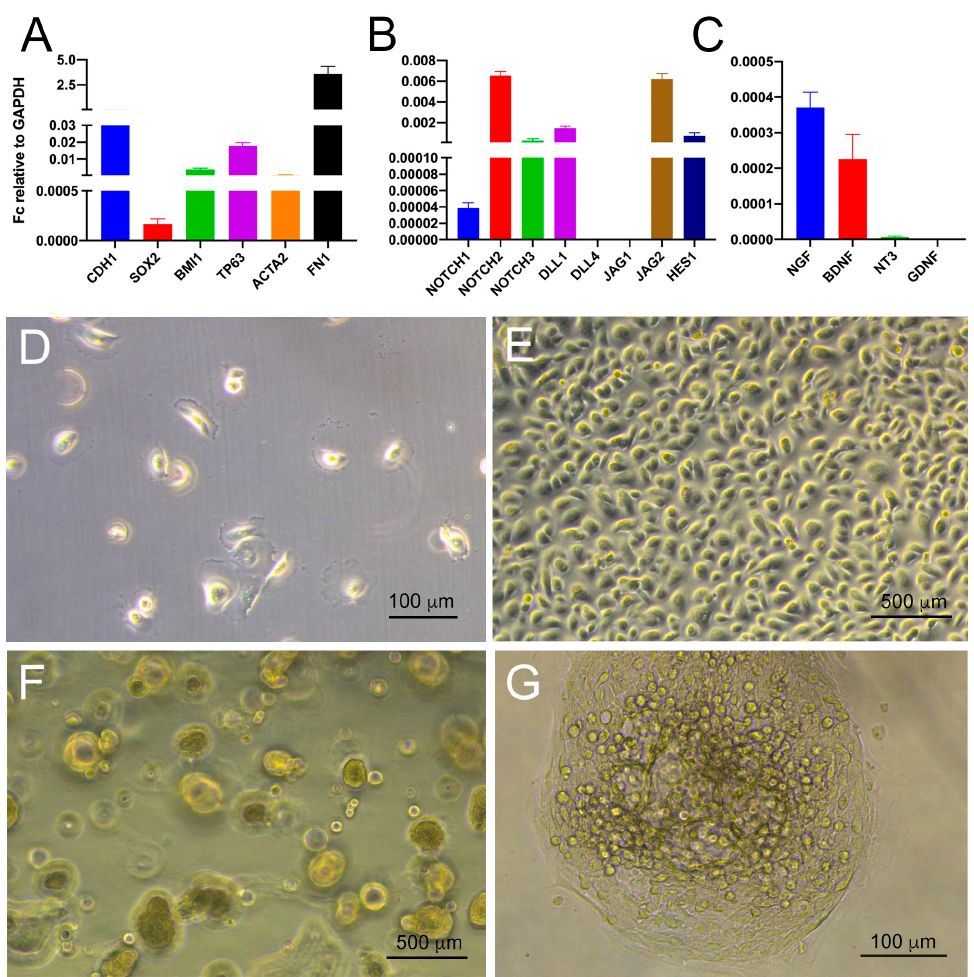
Figure 5. Characterization of AB10 cells. ( A – C ) Real time PCR analysis of the expression of genes coding for epithelial and mesenchymal markers ( A ), for NOTCH pathway components ( B ), and for neurotrophins ( C ). ( D – G ) Brightfield images showing AB10 cells grown in adhesion ( D , E ) and 3D/sphere-forming conditions ( F , G ). Scale bar: D,G: 100 μ m; E, F: 500 μ m.